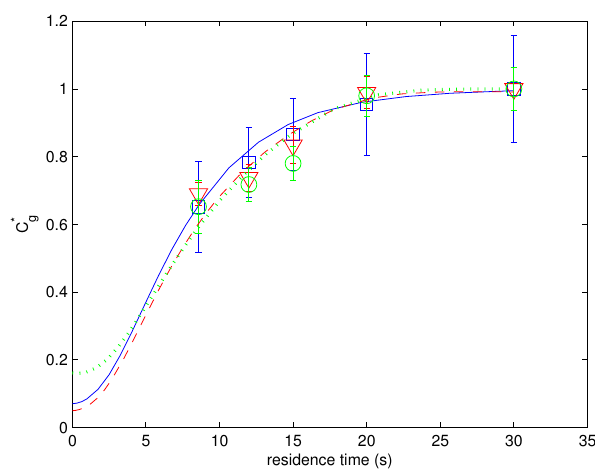
Fig. 3. Measured and simulated vapor build-up profiles for adipic acid aerosol ( C 0 =390µgm − 3 , N tot =10 12 ,particlesm − 3 , d p , cs =65nm) in a TD. The simulations were performed with α as a variable parameter as indicated in the figure. T in =25 ◦ C and T w =40 ◦ C.